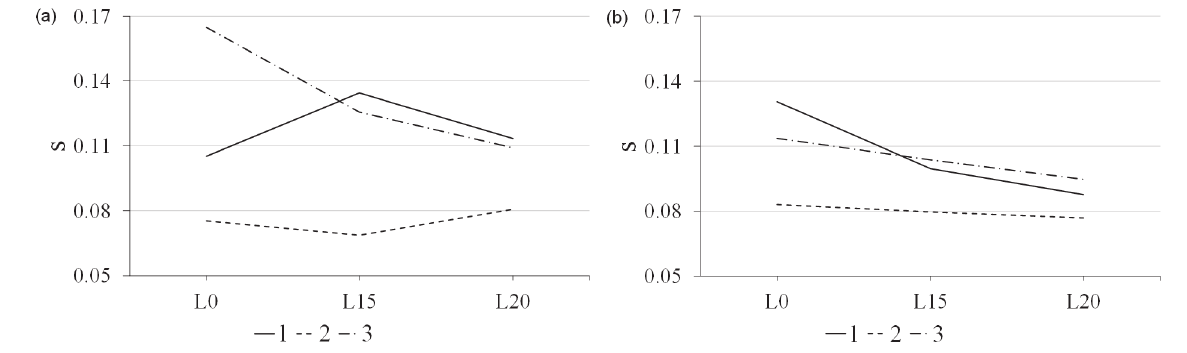
Figure 3 - Pore volumes enclosed by the peaks located in the matrix (1) and structural (2 and 3) porosity domain (see Fig. 1) as a function of the treatments for the ( a ) 0-10 cm and ( b ) 10-20 cm soil